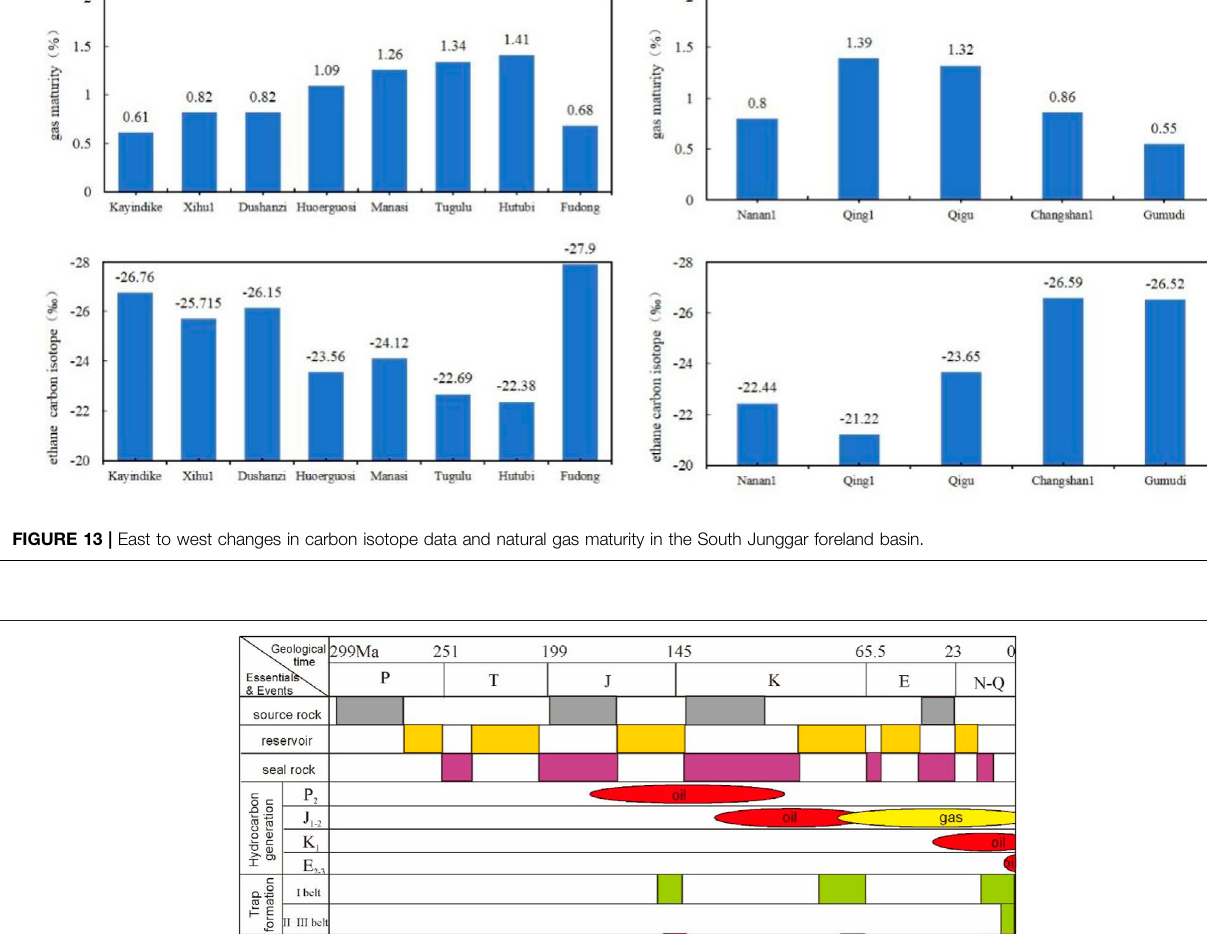
Table 2 . The gas maturity is computed based on the linear relationship between methane carbon isotope and source rock Ro according to the type III source rock. The calculation formula is referred from the two-stage fi tting mode of coal-derived gas after Liu and Xu (1999).